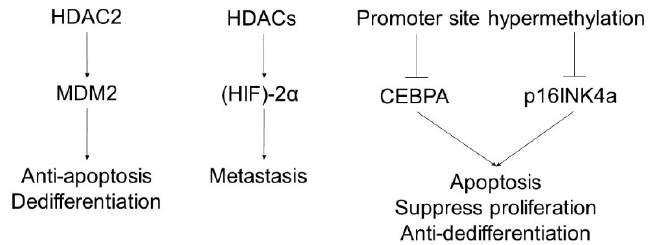
Figure 3. The pathogenesis of liposarcoma and the influence of